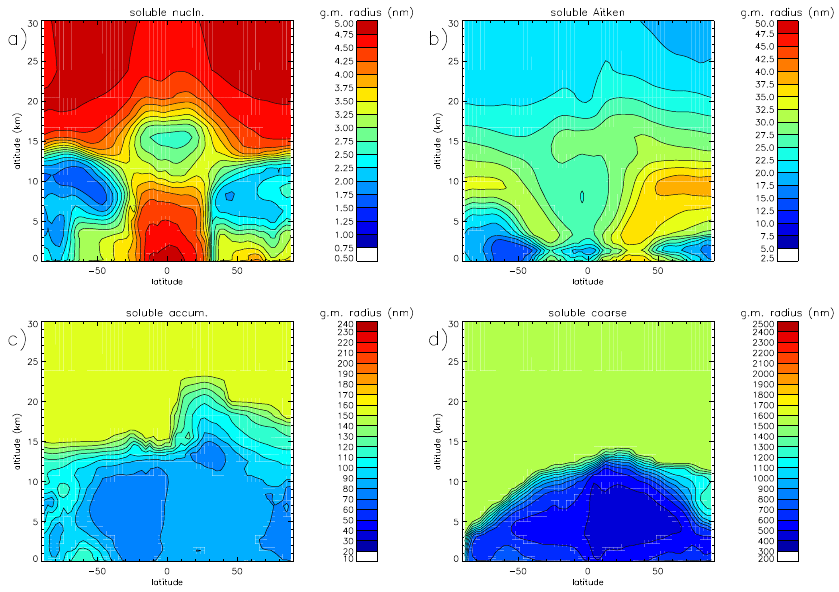
Fig. 14. Latitude-altitude plots of simulated zonal-means of annual-mean particle geometric mean radius for (a) nucleation mode, (b) Aitken-soluble mode, (c) accumulation-soluble mode and (d) coarse-soluble